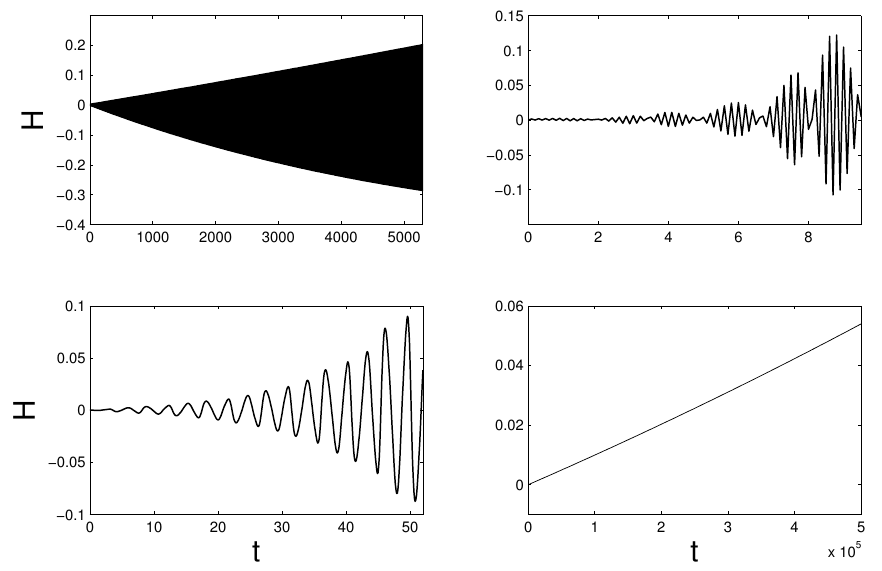
Figure 12. Hamiltonian for the numerical solution of the Lotka–Volterra model obtained with the 2-stage Gauss method ( top left ), the 3- and 4-stage Lobatto IIIA-IIIB schemes ( top right , bottom left ), respectively, and the non-variational Radau IIA method ( bottom right